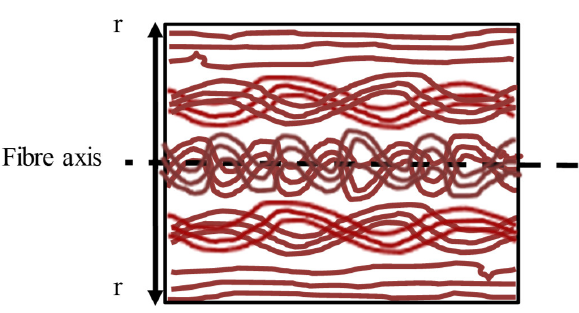
Figure 11. Schematic illustration of radius-dependent polymer chain interaction (and orientation; differences exaggerated for clarity).